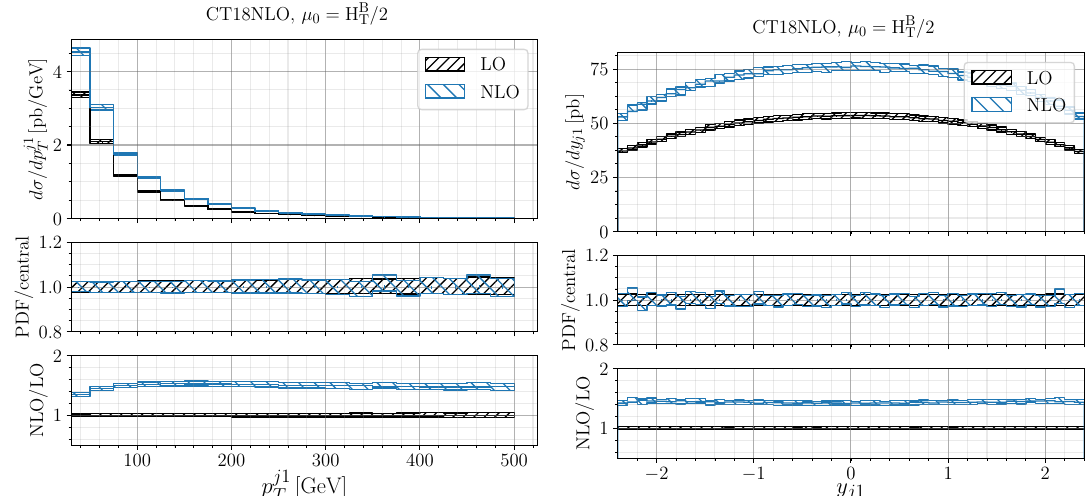
(left) and y j (right) distributions in a full NLO com- T 1 / 2 . PDF uncertainty bands T